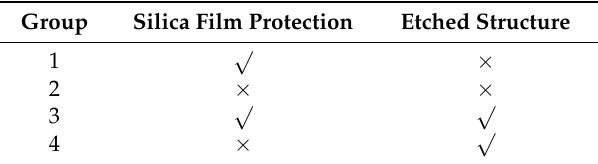
Figure 11. Image processing steps to calculate bonding rate. Table 2. Silica film protection and etched structure details of the